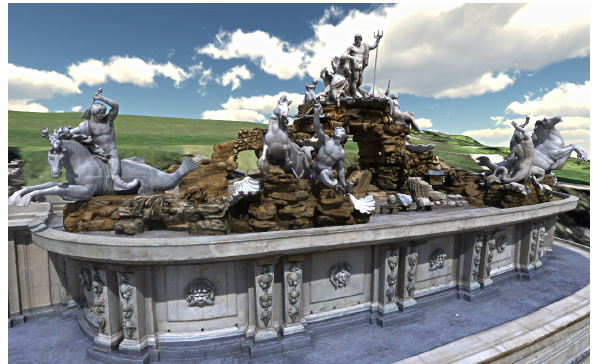
Figure 9. High-resolution 3D real-time rendering of the entire scene.